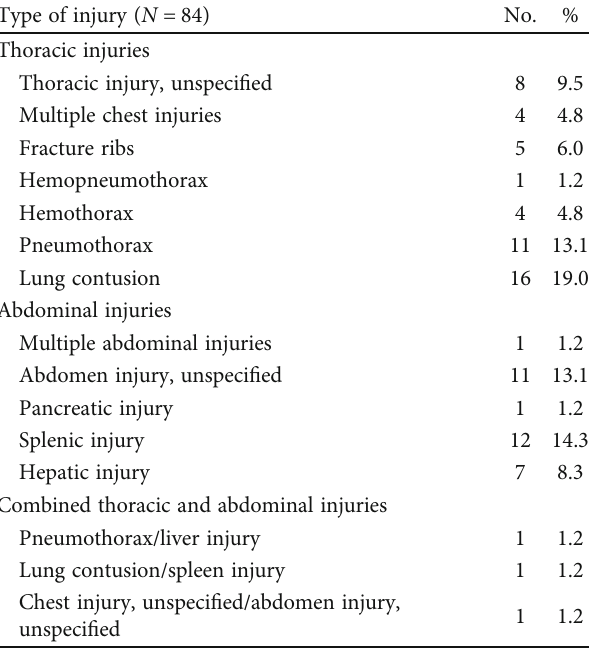
Table 2: Associated thoracic and abdominal